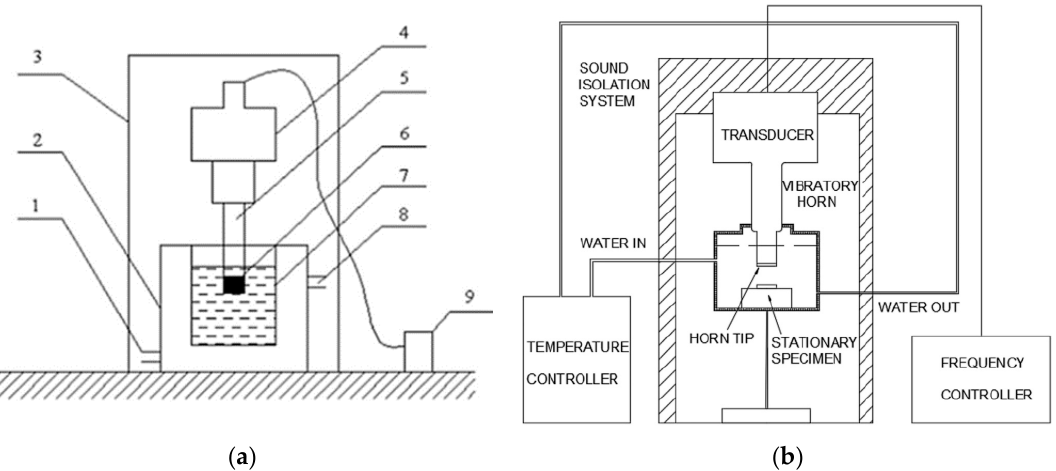
Figure 1. Schematic of the vibratory test devices for ( a ) testing in a direct method, 1: water inlet; 2: